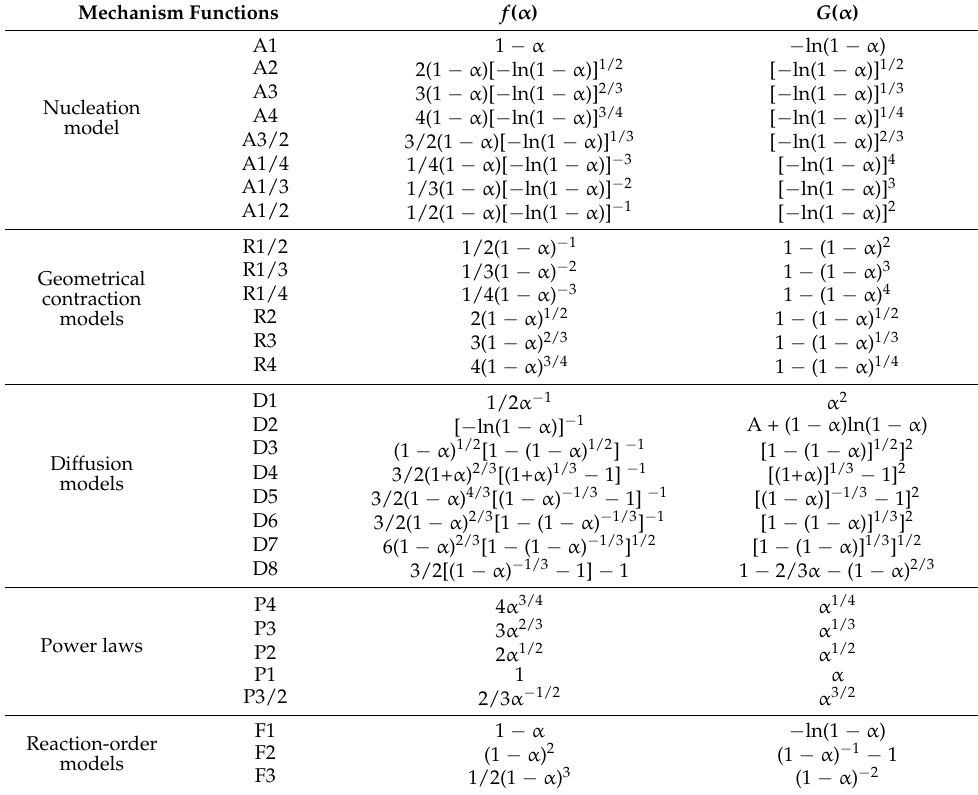
Table 2. Description of the thirty kinetic models used in this